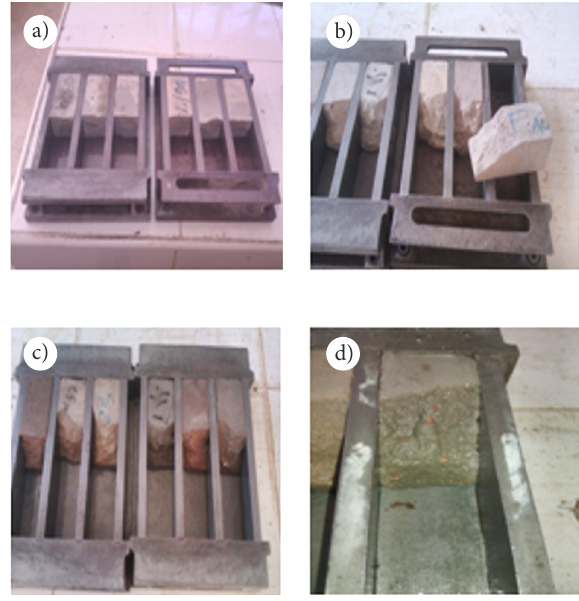
Figure 2. The half-specimen surface saturated with water: a – Dry and rough surface (DR); b – Wet and rough oblique surface (DRO); c – Wet and rough surface